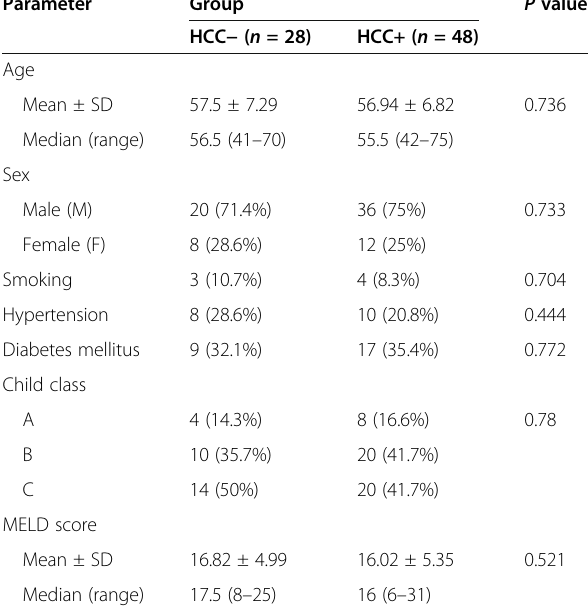
Table 2 Baseline patient characteristics